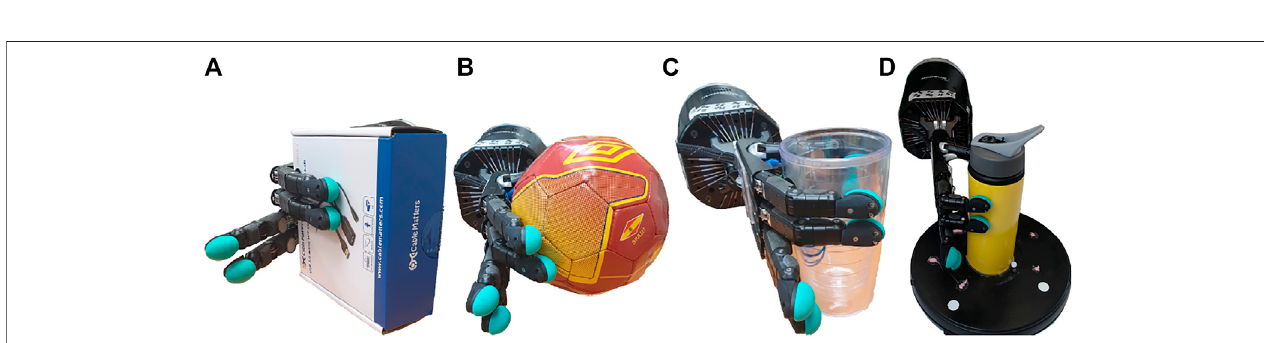
FIGURE10| ObjectsUsedforLongitudinalandRotationalSlipDetection. (A) Boxshape, (B) Sphericalshape, (C) Cylindershape, (D) Tumbleronconstant-speed turntable.